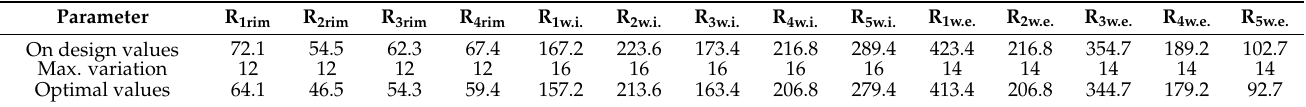
Table 1. Layer profile geometric parameters.